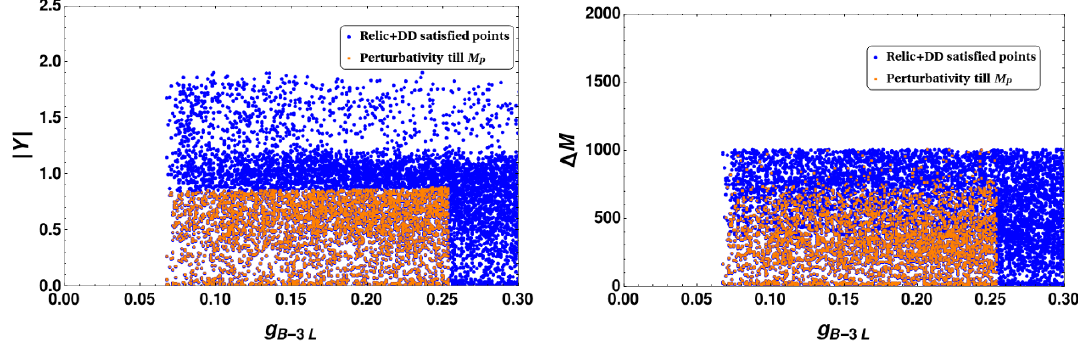
Figure 8 . Parameter space satisfying DM relic and direct detection bounds (blue points) and perturbativity/unitarity till M P (orange points) are shown in (left) Y (cid:0) g B (cid:0) 3 L (cid:1) M (cid:0) g B (cid:0) 3 L (cid:28)